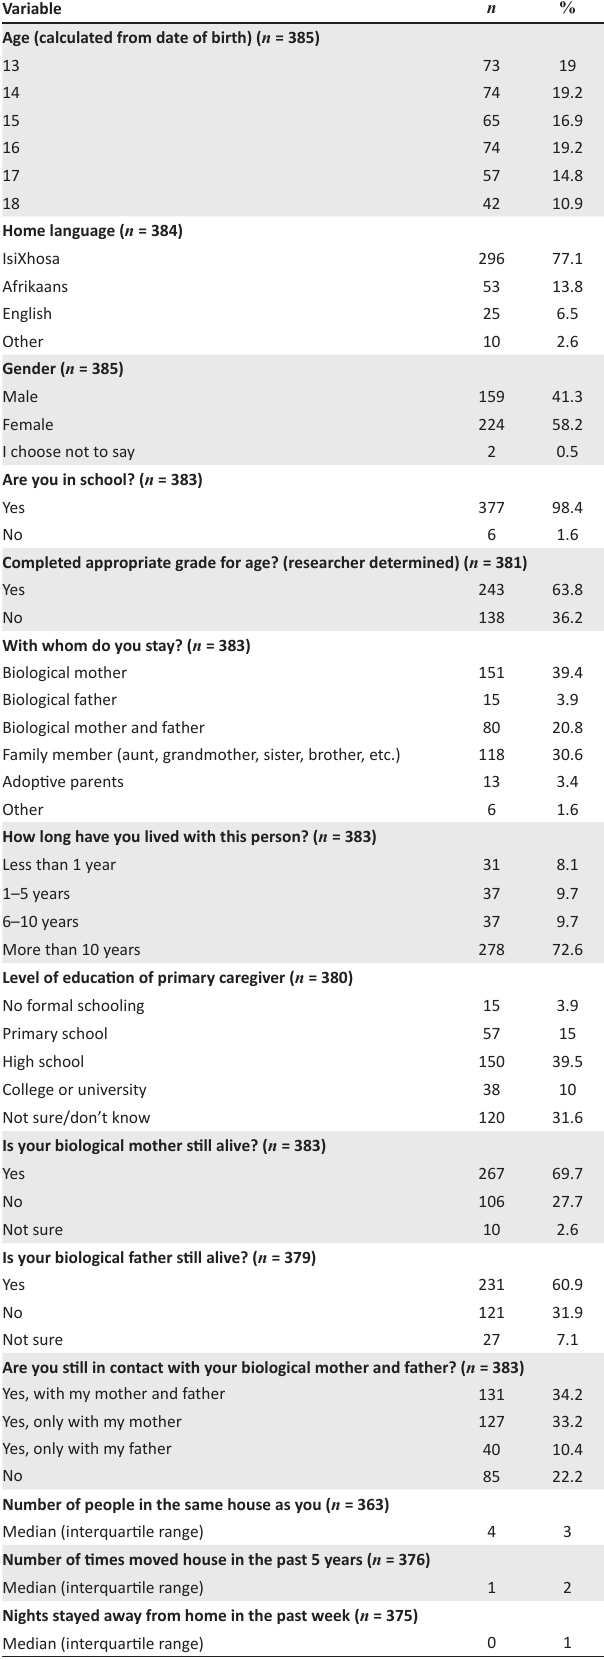
TABLE 2: Demographics of the study sample. TABLE 2 (Continues...): Demographics of the study